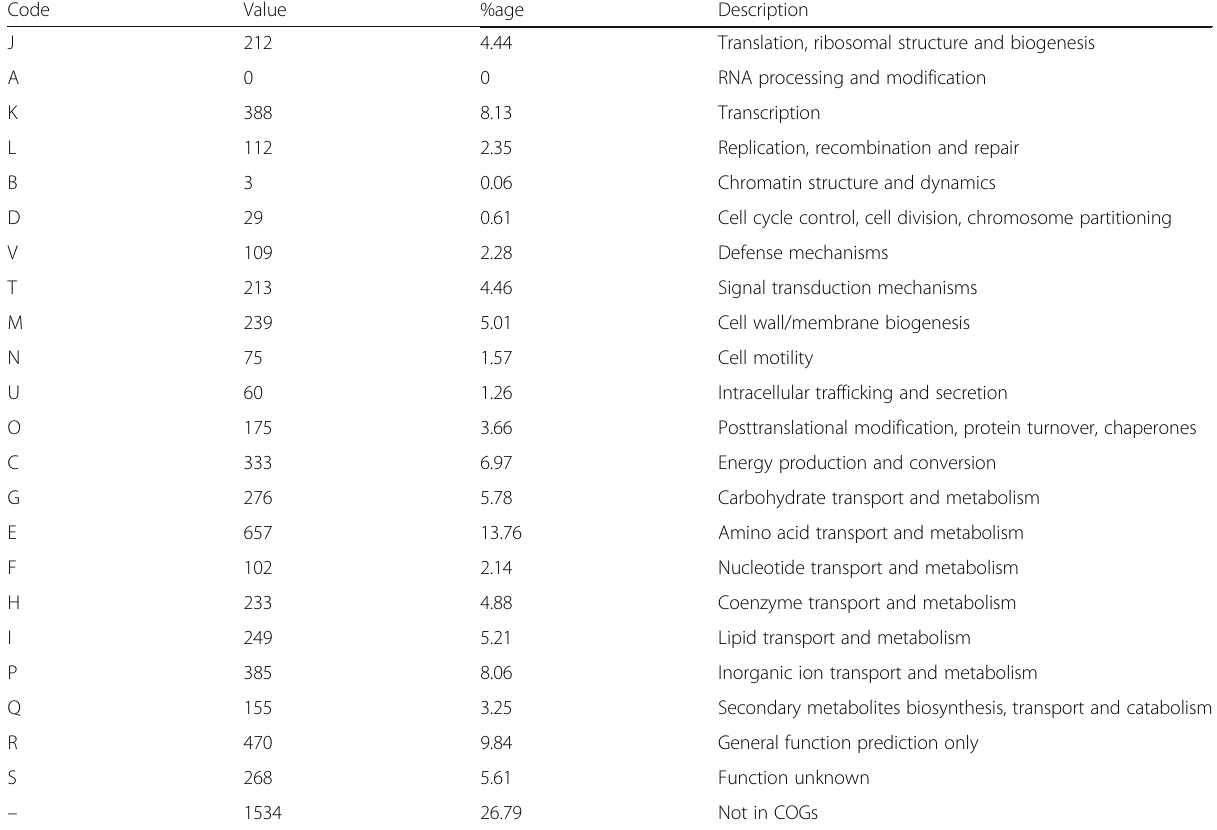
Table 4 Number of genes associated with general COG functional